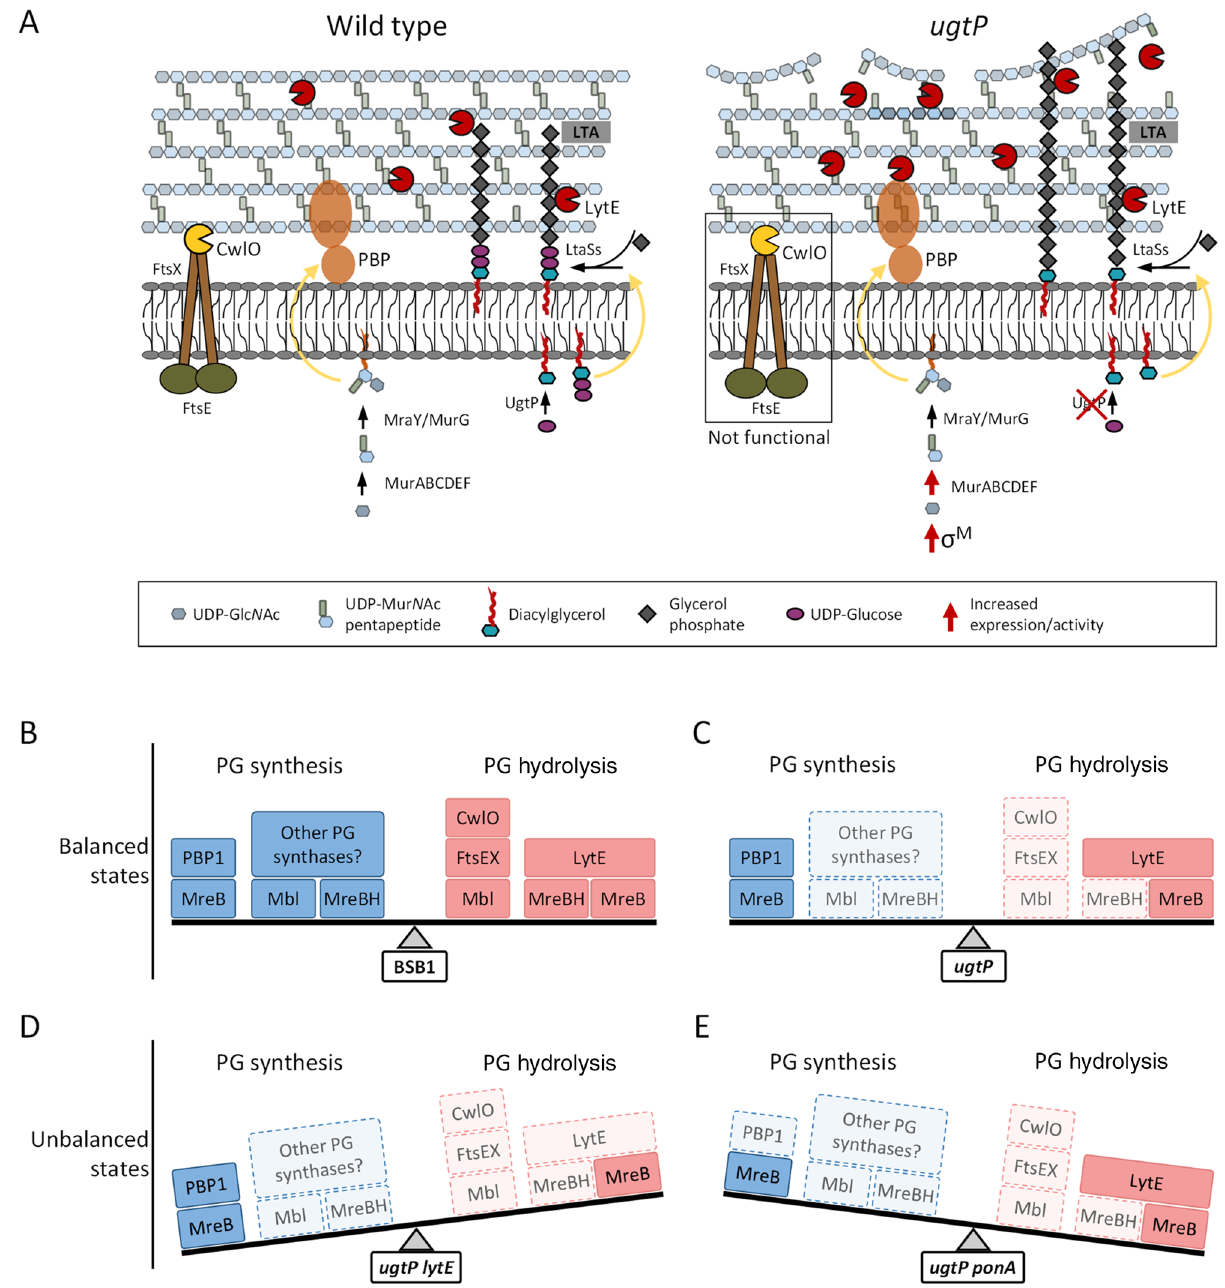
Figure 6. Schematic representation of the cell wall changes occurring in the ugtP mutant. ( A ) The genetic evidence in this work suggests that in comparison to wild type cells (left panel), cells lacking UgtP (right panel) showed lower CwlO activity, an increase in the PG precursor levels resulting in an upturn in PG synthesis and an increase in the LytE endopeptidase activity. These results support the idea that the ugtP mutant maintain its cell wall integrity and rod-shape by balancing the increased PG synthesis (PBP1) and hydrolysis (LytE). A representation of the proteins involved in peripheral PG synthesis or hydrolysis in wild type cells and the mutants studied in this work are shown in panels ( B – E ). Dark coloured boxes represent functioning proteins and light coloured boxes represent malfunctioning proteins. ( B ) BSB1 cells had functional proteins resulting in balanced PG synthesis and hydrolysis. ( C ) Δ ugtP cells exhibited a malfunction in several proteins involved in PG synthesis and/or hydrolysis, such that the cell maintains a healthy balance between PG synthesis and hydrolysis. ( D ) Δ ugtP Δ lytE cells and ( E ) Δ ugtP Δ ponA cells showed a malfunction in several proteins however, these mutants exhibited a misbalance in PG synthesis and/or hydrolysis resulting in loss of rod-shape and cell death. Therefore, a balanced synthesis and hydrolysis, potentially by the same cytoskeleton system, is important for PG synthesis and cell